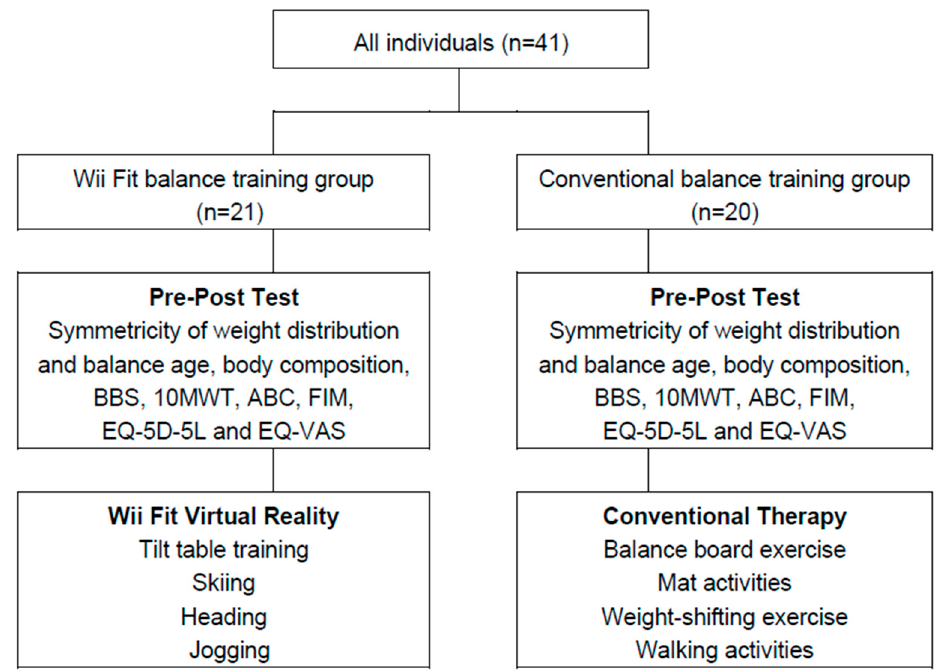
Figure 1. Procedures of the study.